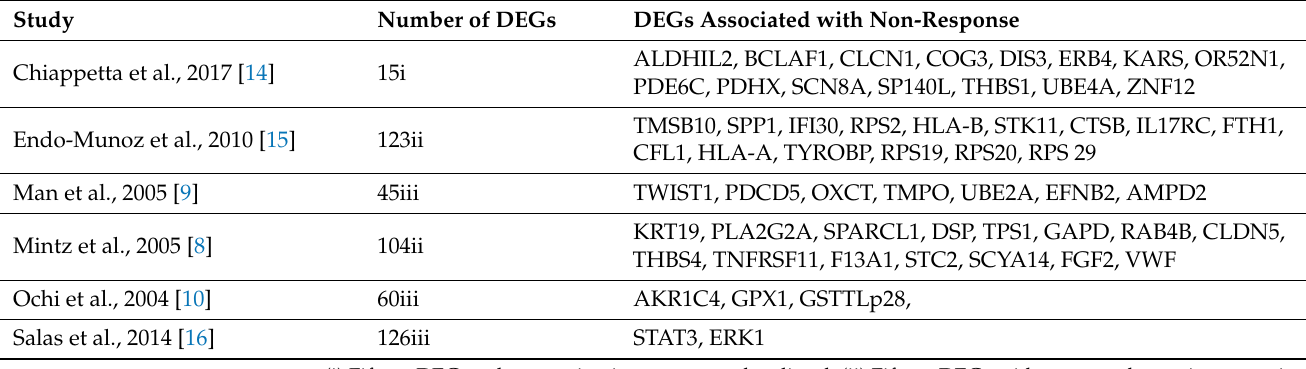
Table 2. Fifty-seven genes associated with a poor response to chemotherapy.